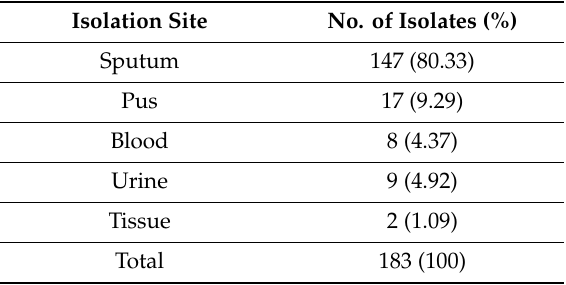
Table 1. Specimentypesfromwhichcarbapenem-resistant Acinetobacterbaumannii isolateswererecovered.